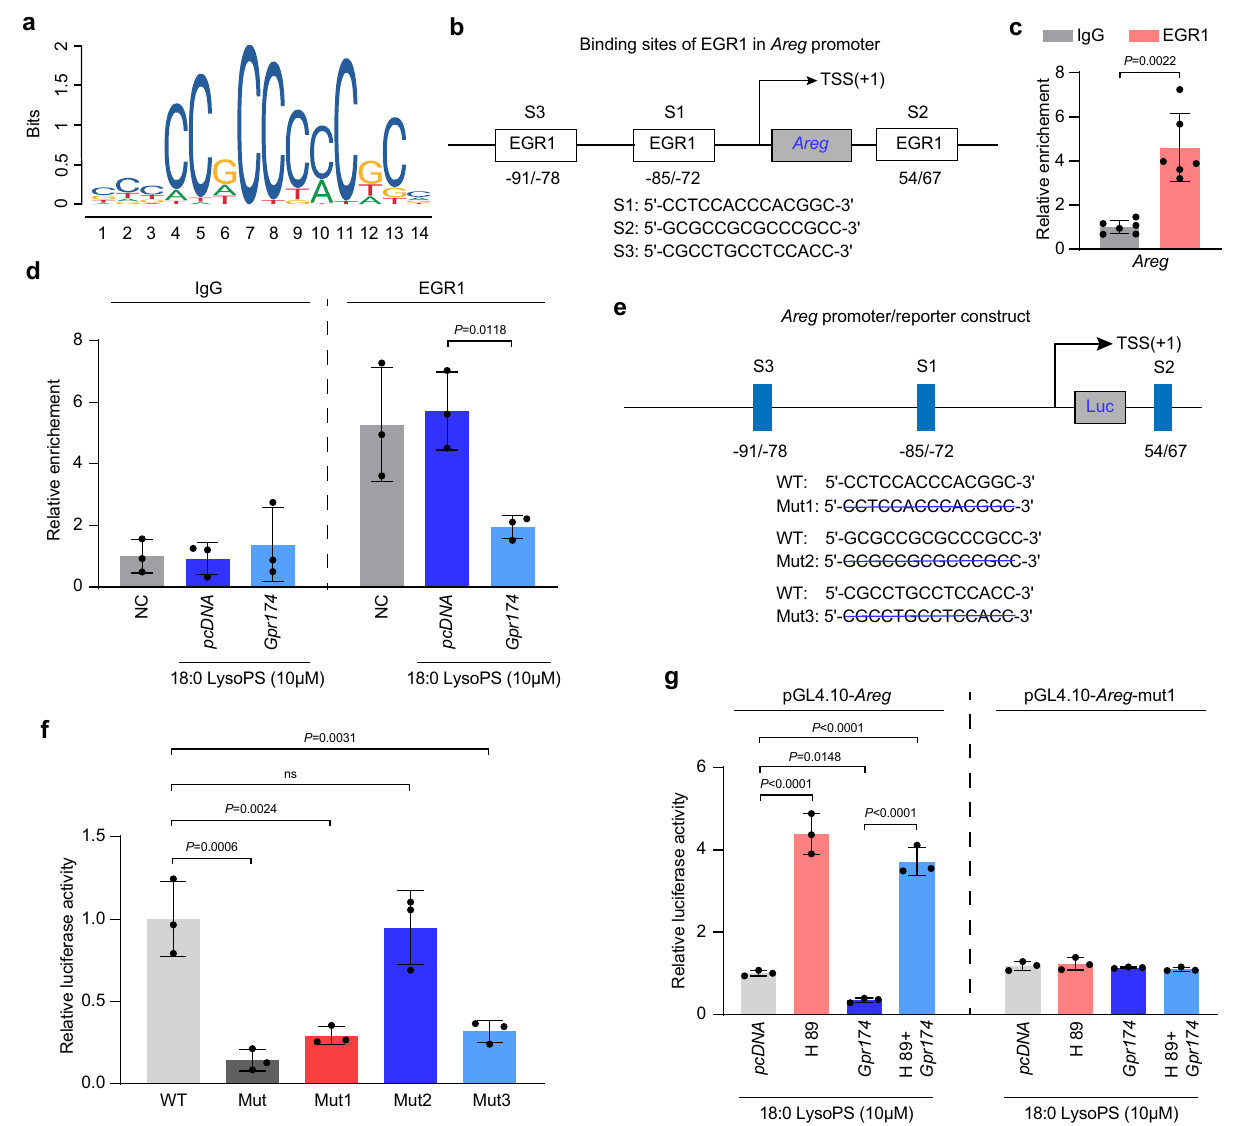
endothelial cells. These fi ndings indicated that Treg-speci fi c GPR174